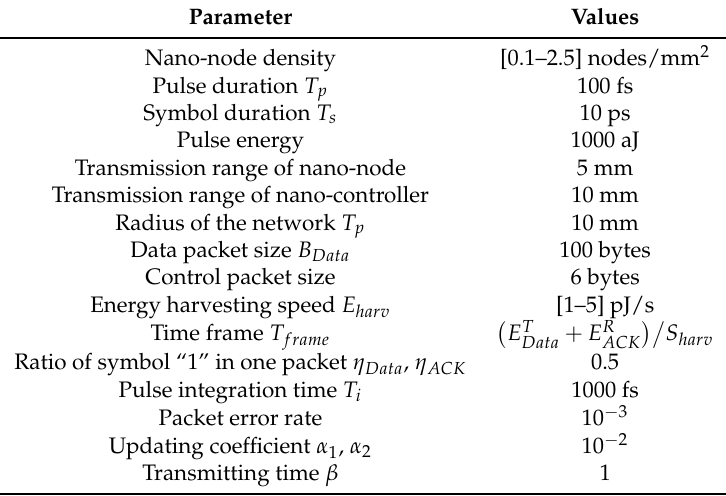
Table 1. Simulation